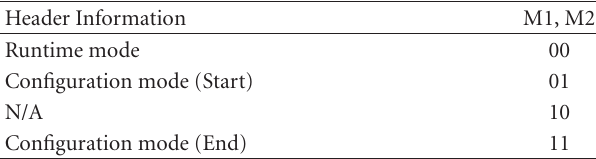
Figure 4: General Packet Format. Table 1: Packet header definitions.